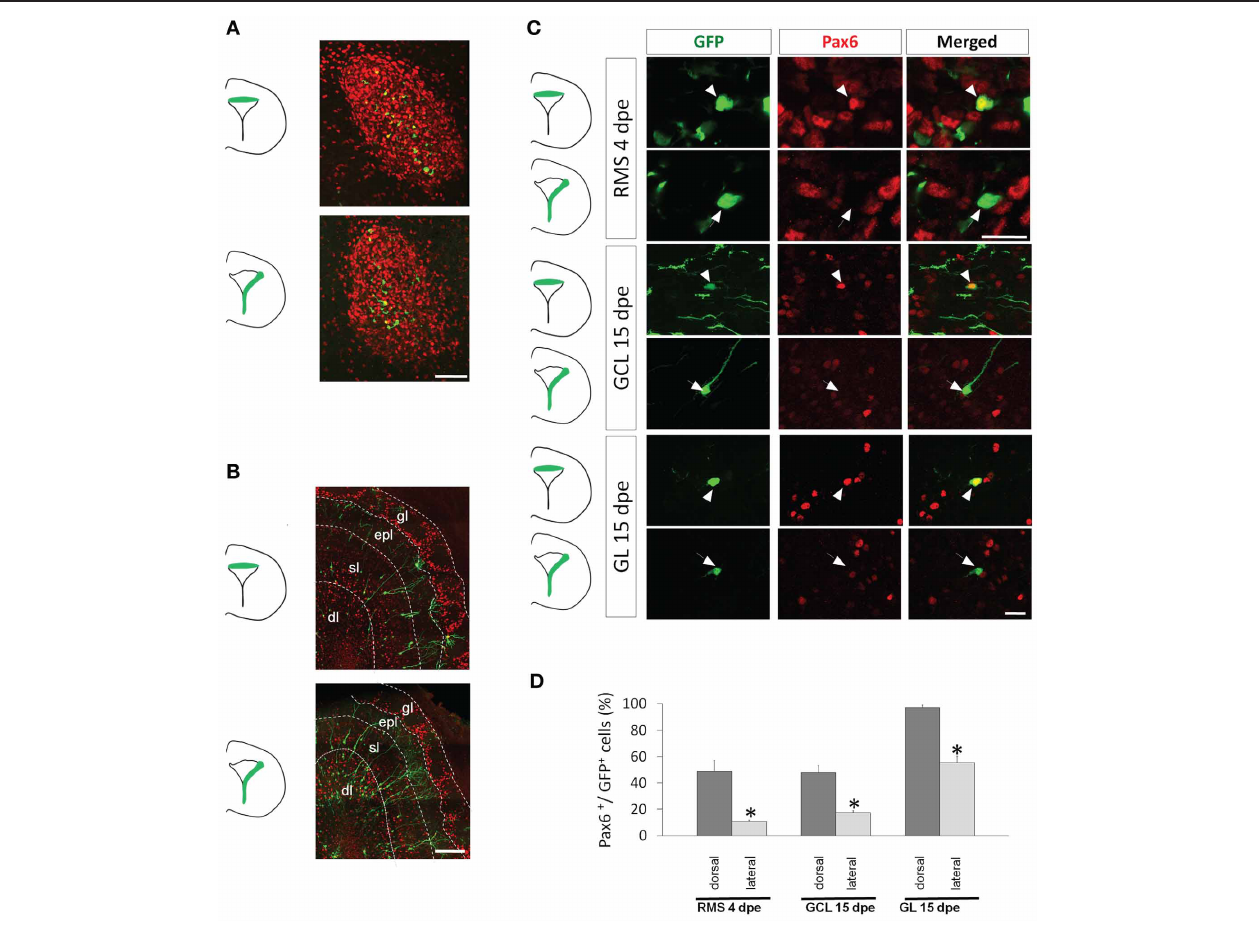
at 4 or 15 dpe. These images show that dorsally but not laterally generated GFP + cells in the RMS and in the granule cell layer (GCL) or glomerular layer (GL) of the OB express Pax6. (D) Histograms representing the percentage of GFP electroporated cells expressing Pax6 4 days after electroporation in the RMS and 15 days after electroporation either in the GCL or in the GL, after dorsal (dark gray bars) or lateral (light gray bars) electroporation ( n = 3–5 mice per group). Scale bars: A, 50 μ m; B, 200 μ m; C, 20 μ